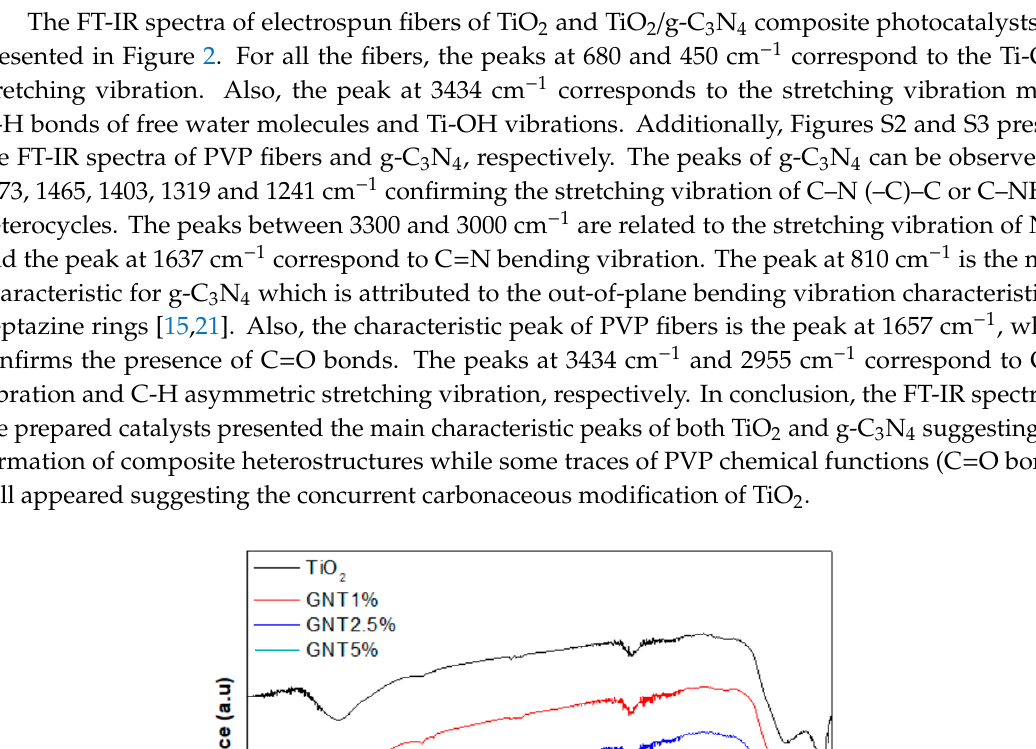
Figure 1. XRD patterns of calcinated TiO 2 fibers and composite TiO 2 / g-C 3 N 4 fibers.